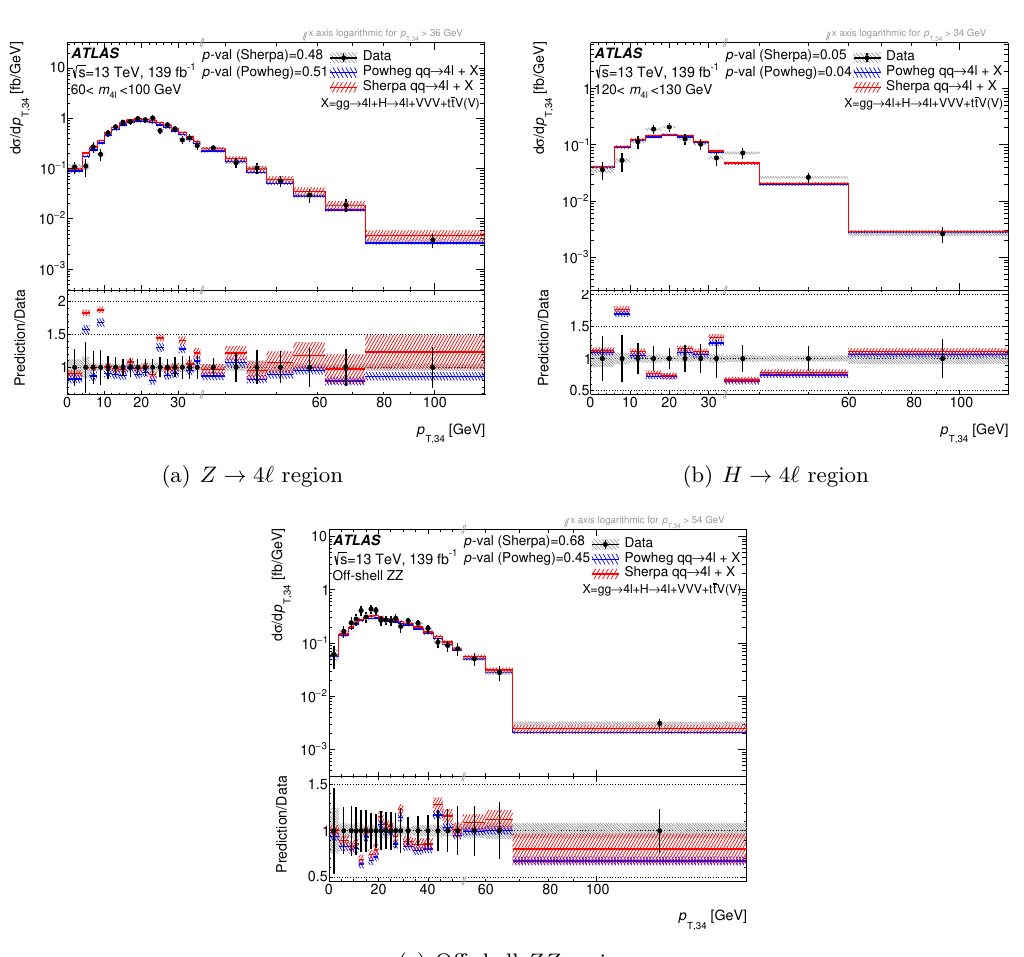
Figure 18 . Differential cross-section as a function of p T , 34 in m 4 ‘ regions. The measured data (black points) are compared with the SM prediction using either Sherpa (red, with red hashed band for the uncertainty) or Powheg + Pythia8 (blue, with blue hashed band for the uncertainty) to model the q ¯ q → 4 ‘ contribution. The error bars on the data points give the total uncertainty and the grey hashed band gives the systematic uncertainty. The p -value is the probability for the χ 2 , with the number of degrees of freedom equal to the number of bins in the distribution, to have at least the observed value, given the SM prediction. The lower panel shows the ratio of the SM predictions to the data. In (a) the x -axis is on a linear scale until p = 36 GeV, where it switches T , 34 to a logarithmic scale; in (b) it switches at p = 34 GeV, and in (c) at p = 54 T , 34 T , 34